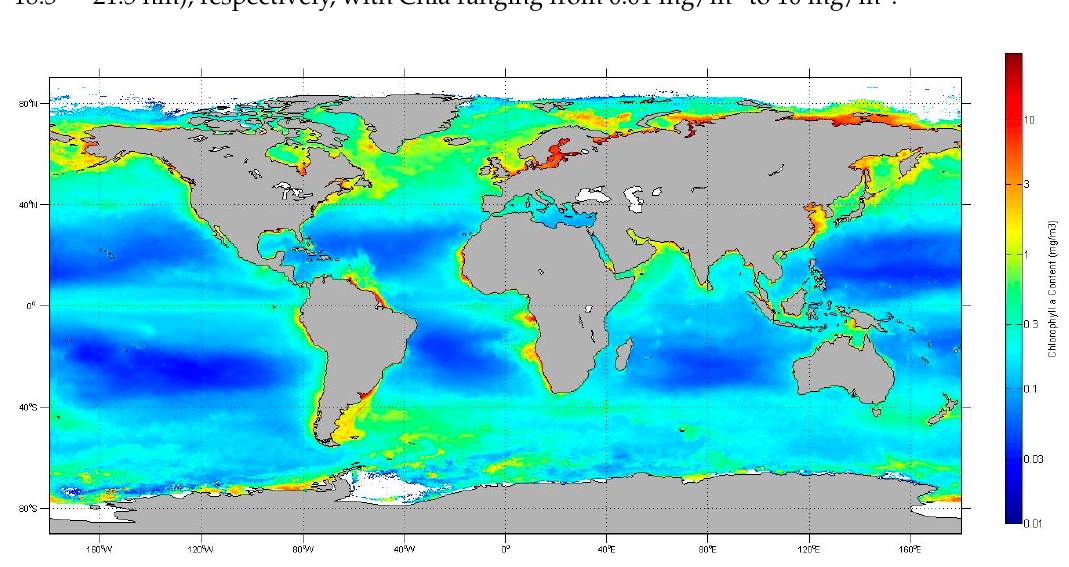
Figure 4. Annual average of the global chlorophyll a concentration distribution in 2010, which was merged from AQUA MODIS (Moderate-resolution imaging spectra-radiometer), ENVISAT MERIS (Medium-spectral Resolution Imaging Spectrometer), and FY-3 MERSI (Medium Resolution Spectral Imager) [23]. The areas in dark blue are characterized by low Chla ( ≤ 0.1 mg/m 3 ), where the noticeable OOB (out-of-band) effect ( ≥ 2%) in the CZI green band need be corrected.